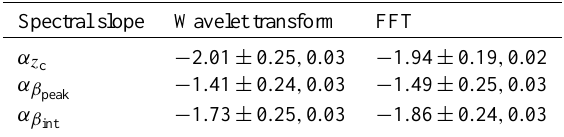
Table 1. Average spectral slopes α of time series of the NLC pa- rameters z c , β peak and β int . Given are the mean value, the standard deviation and the statistical error of the mean.